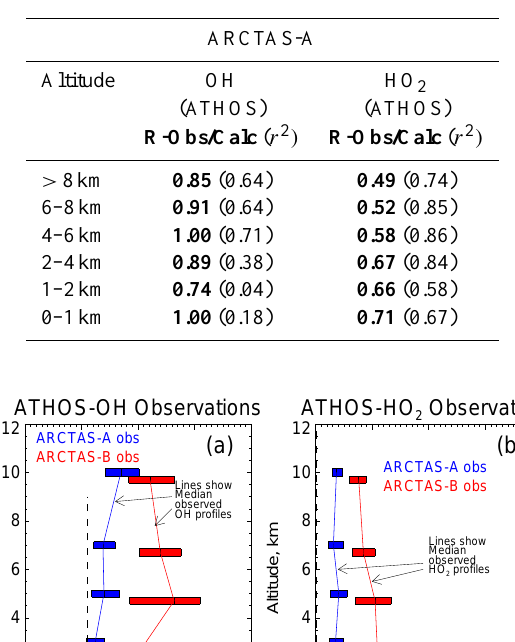
Table 5. Median Observed-to-Calculated Ratios and ( r 2 ) for HO x .